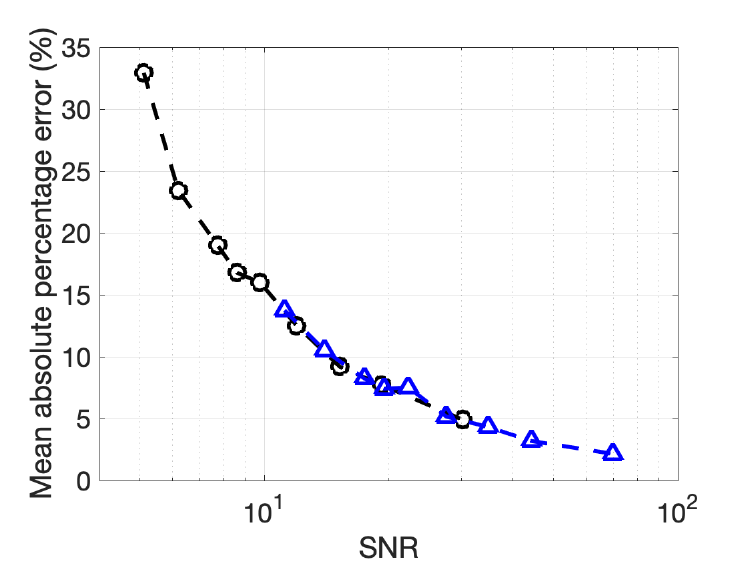
Figure A2. Mean absolute percentage error, M , vs SNR for 5 S 1/2 → 6 P 1/2 (black circles), 6 P 3/2 , (blue triangles) for n = 200 repeats. Dashed lines are to guide the eye